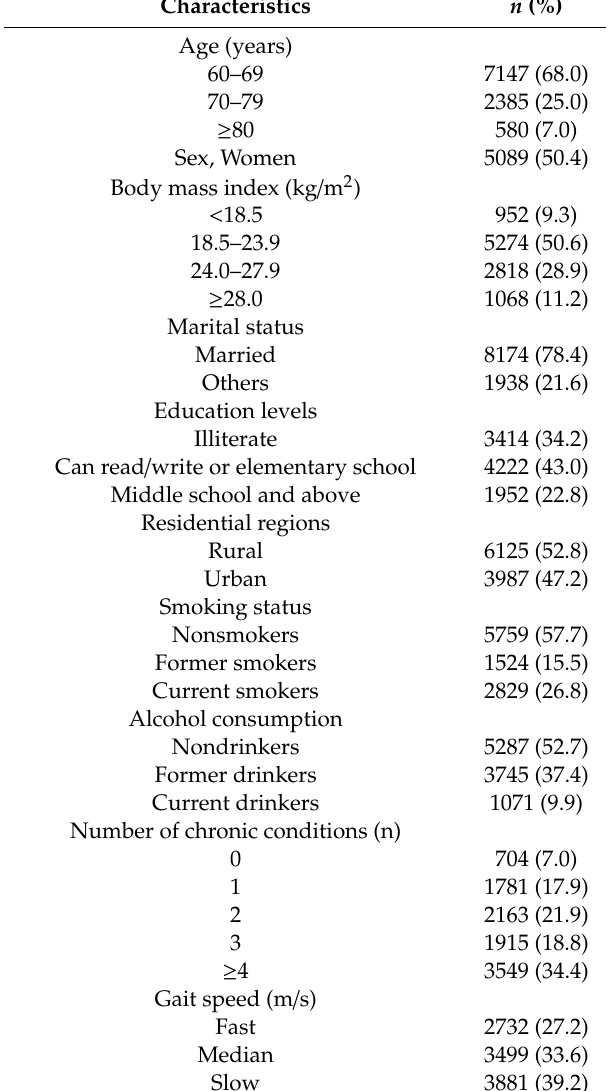
Table 1. Baseline information of characteristics of participants (N =